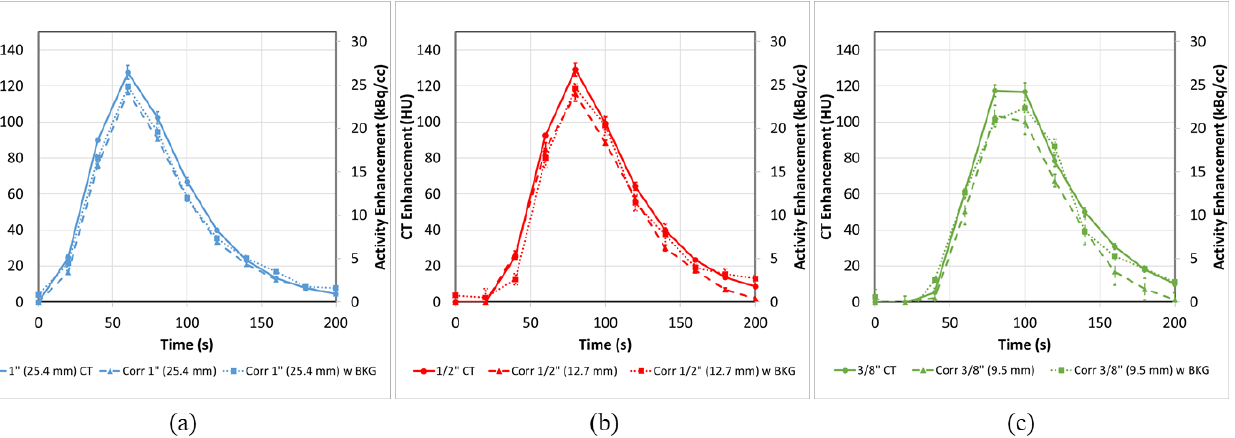
10 Figure 7. PVE in dPET Input functions at all tube sizes ( a ) 1” (25.4 mm), ( b ) ½” (12.7 mm) and ( c ) 3/8” (9.5 mm) can be substantially corrected even in conditions of background activity. The substantial PVE observed in the uncorrected (solid lines) input function can be corrected (dashed lines) by as much as 49 ± 15% for the 3/8” tube based on AUC. Error bars represent the standard error from multiple ROI regions (n = 5).